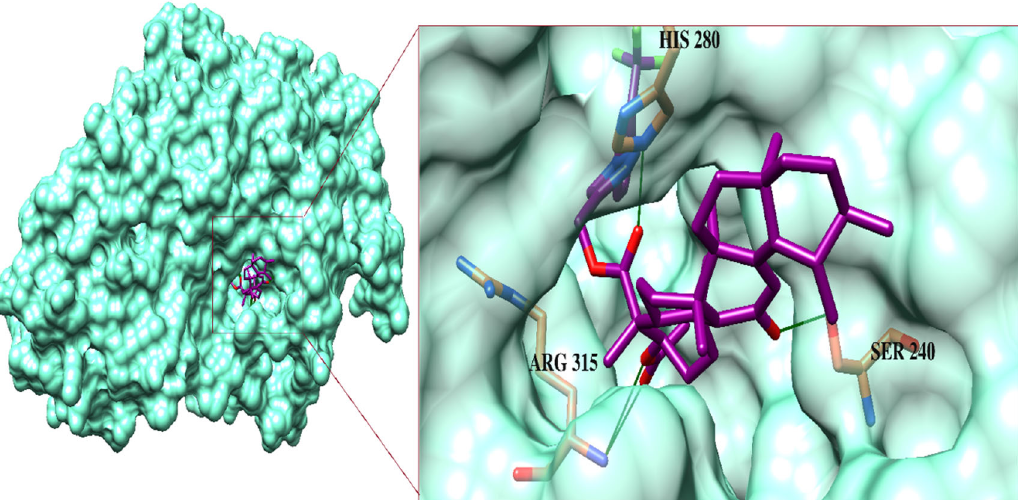
Figure 5. The binding mode of the most active compound, 6f (shown in the purple stick model), in the active site of enzyme. The ligand ‐ binding residues are presented in the orange stick model and H ‐ bonds are shown in green lines.